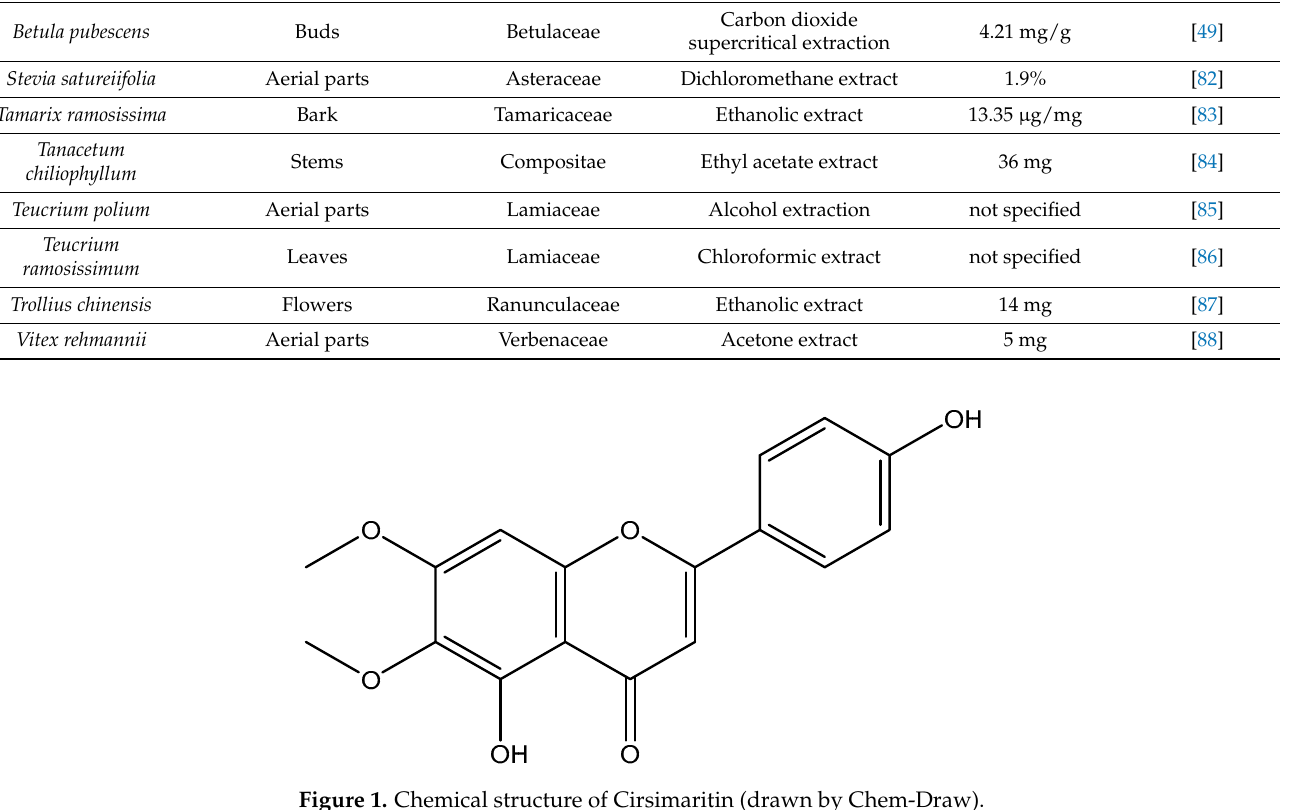
Figure 1. Chemical structure of Cirsimaritin (drawn by Chem-Draw).